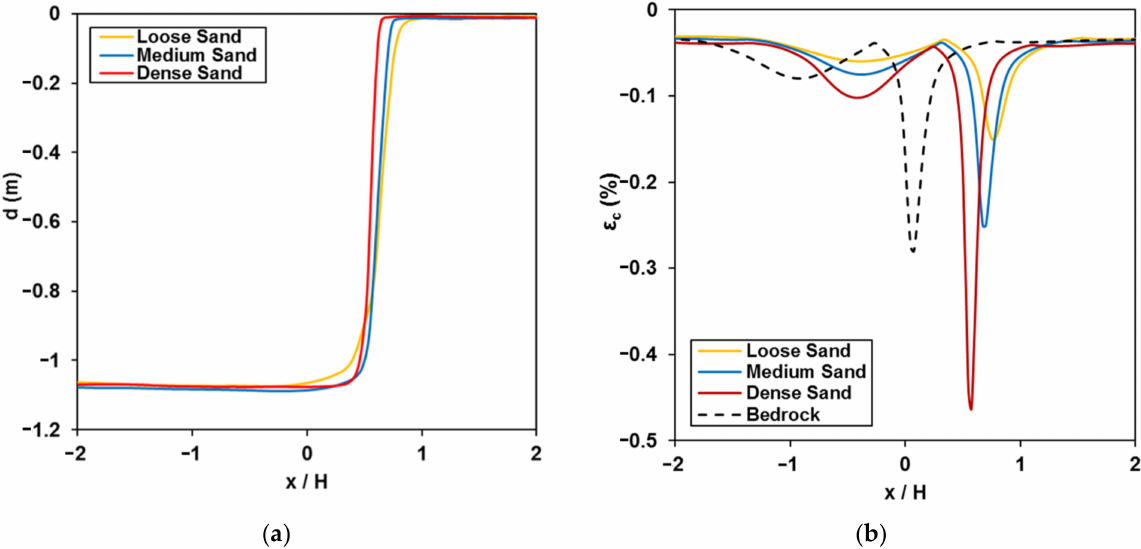
Figure 8. Impact of soil properties on: ( a ) the PGDs at the surface; ( b ) pipe compressive